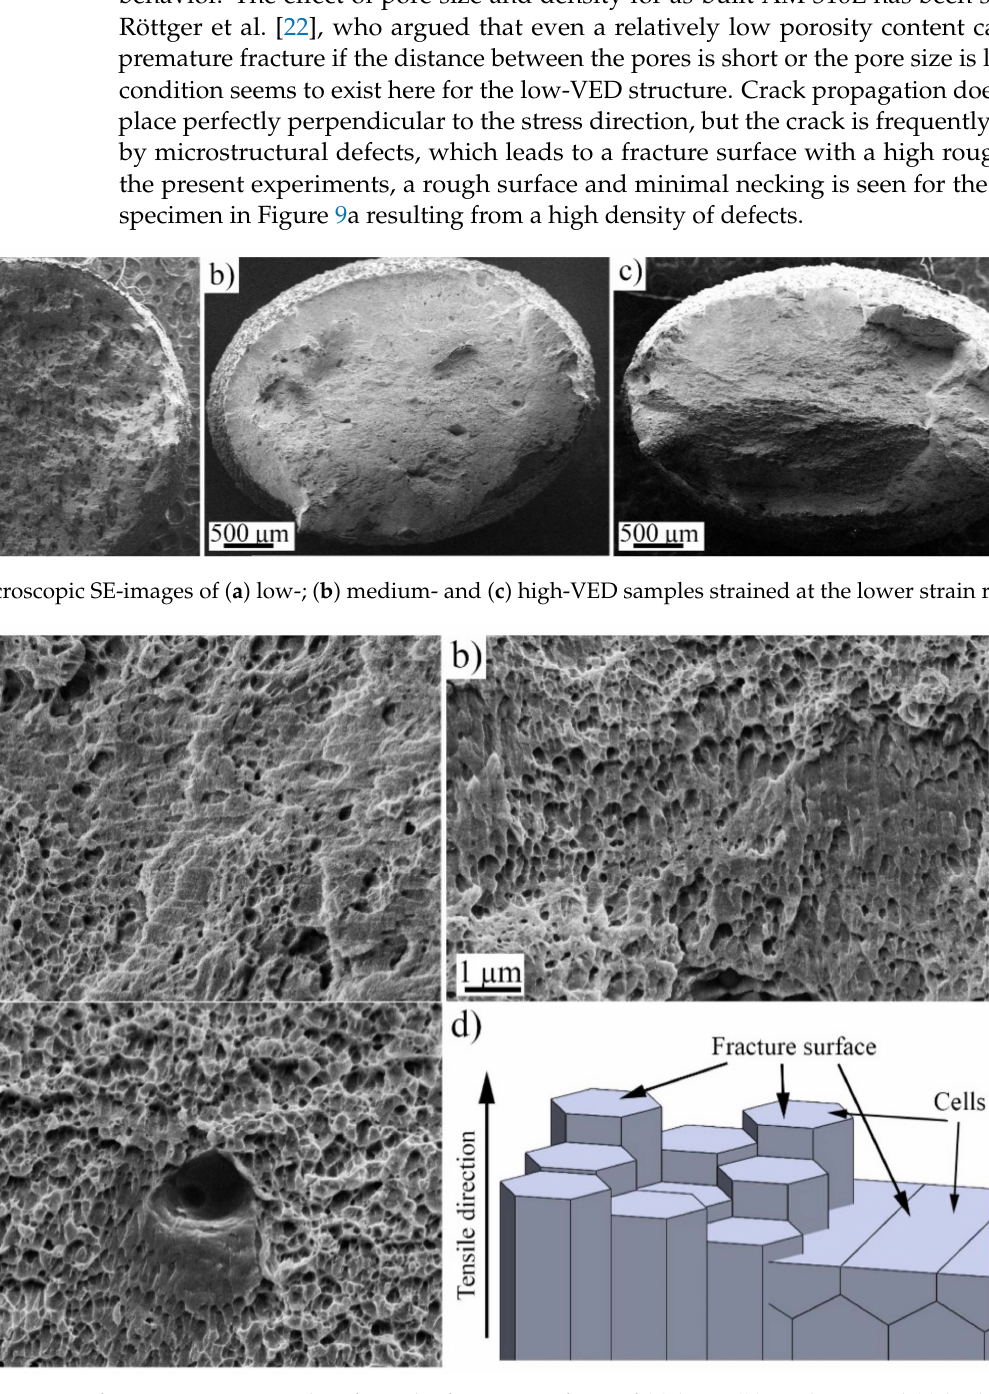
Figure 10. Higher magnification SE-images taken from the fracture surfaces of ( a ) low-; ( b ) medium; and ( c ) high-VED specimens strained at lower strain rate and ( d ) illustration of the fracture